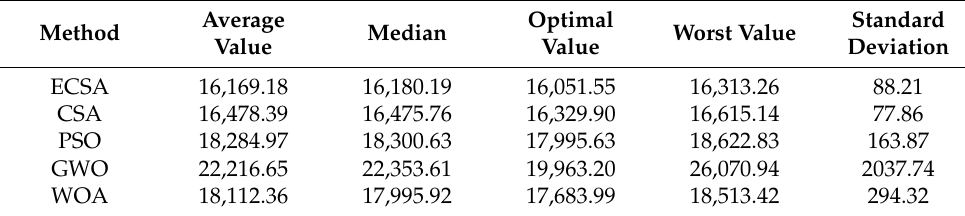
Table 10. Statistical table of pollutant gas emission structure of five algorithms (unit: kg).